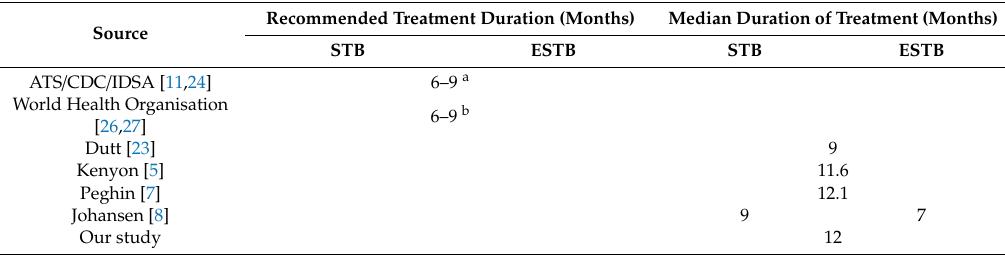
Table 5. Recommended and documented duration of treatment for